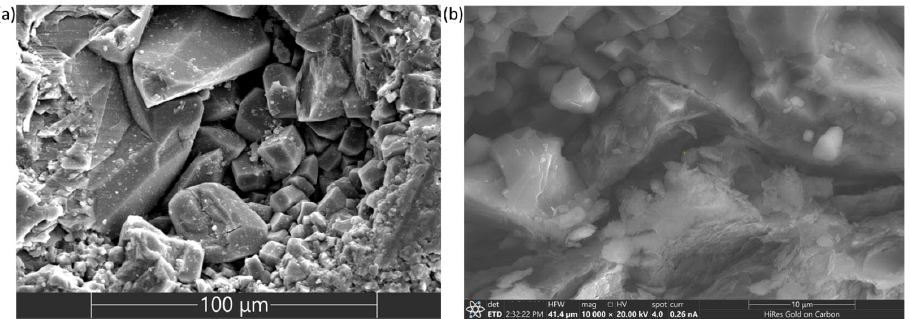
Figure 13. Electron microphotographs showing the structure of carbonate geomaterial: ( a ) various calcite crystal shapes, such as rhombohedral, scalenohedral (the large crystal at top center) and crystals of other types; ( b ) a system of microcracks.